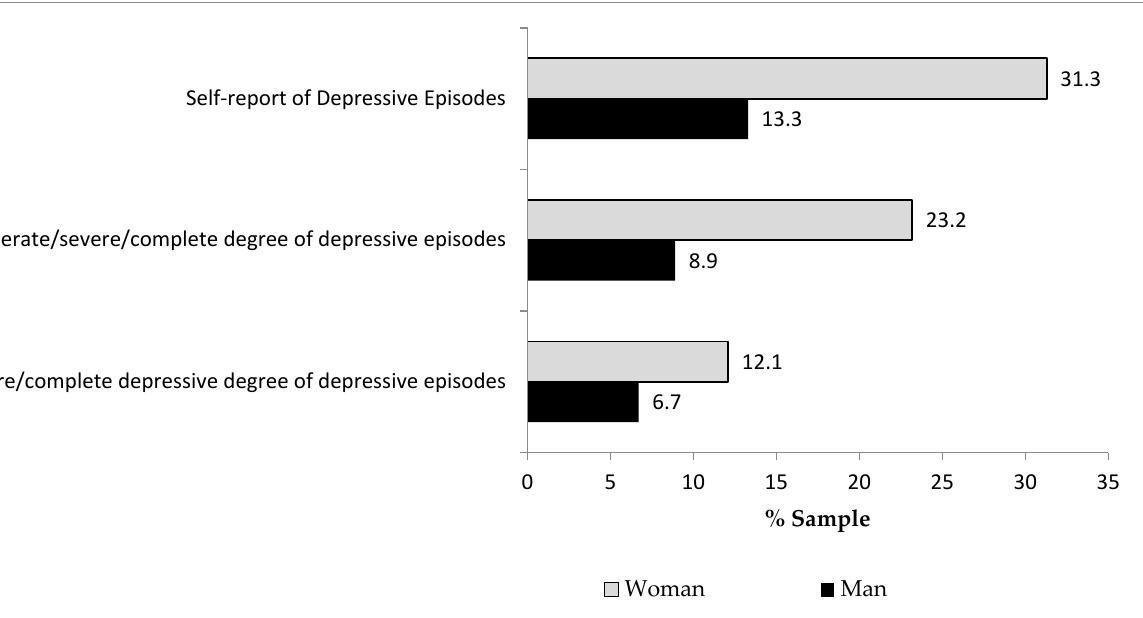
Figure A5. Self-report of depressive episodes according to the professional’s gender.